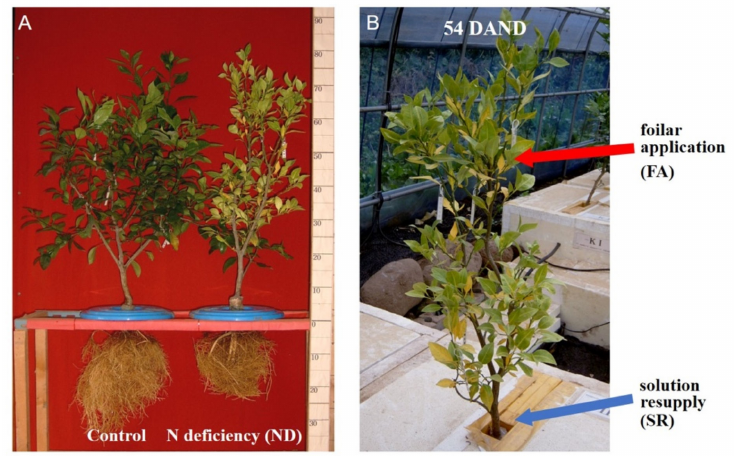
Figure 8. Experimental groups. ( A ) Representative plants in the control and ND groups. ( B ) Repre- sentative plants in the FA and SR